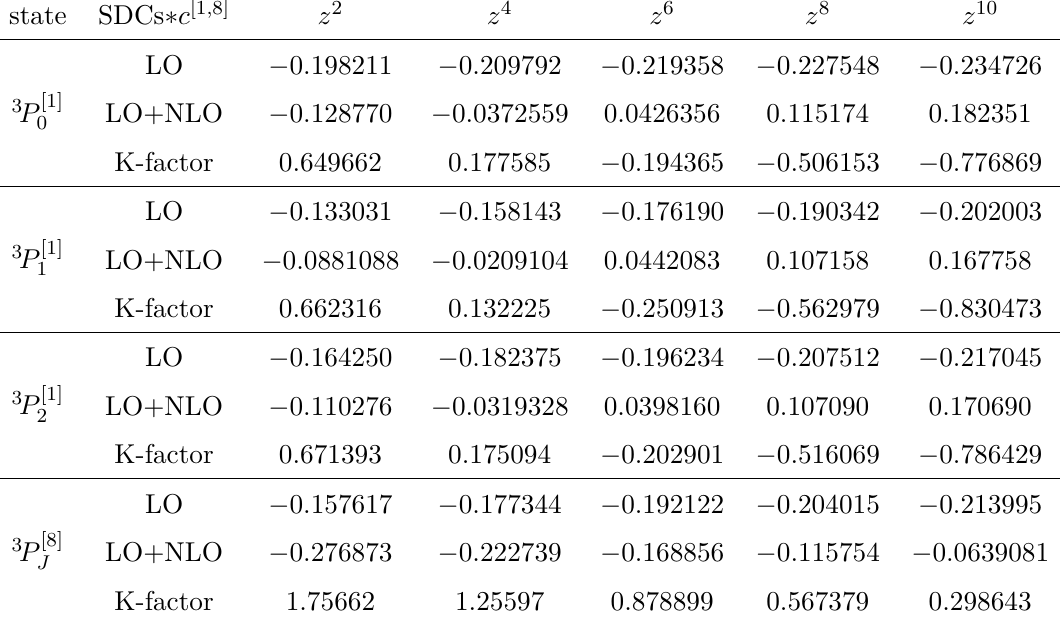
Table 3 . Moments and K-factors of c ¯ c SDCs.